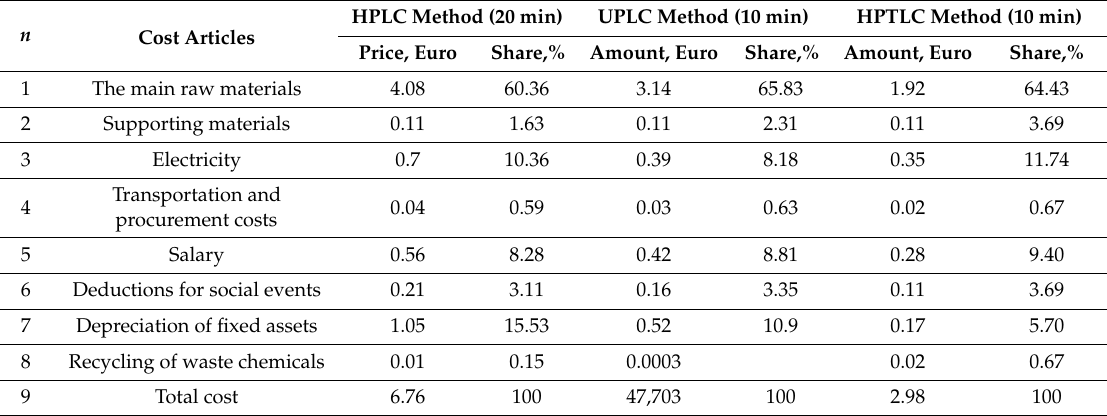
Table 9. Cost of analytical research by HPLC, UPLC, HPTLC analysis methods. Calculation unit—1 sample